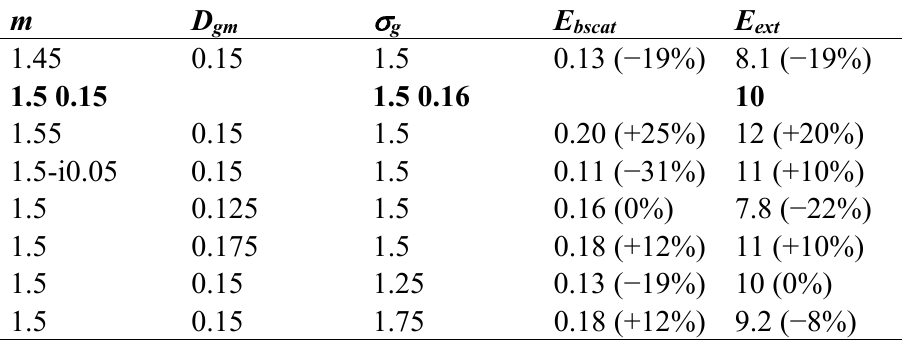
Table 2. Sensitivity of calculated mass efficiencies: spark-ignition